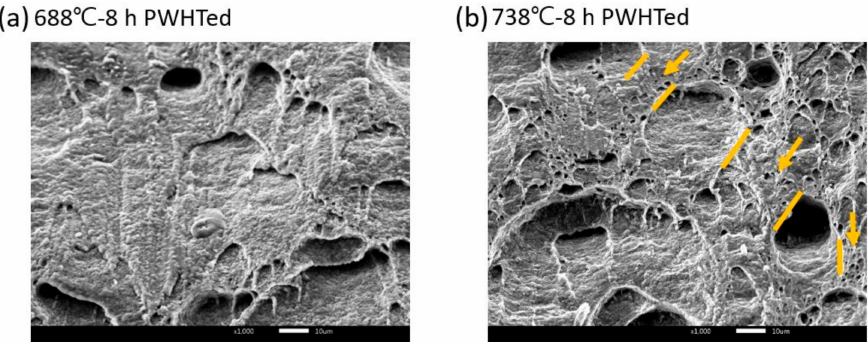
Figure 11. Typical fracture morphologies of creep specimens with different PWHT conditions: ( a ) 688 ◦ C-8 h and ( b ) 738 ◦ C-8 h PWHTed